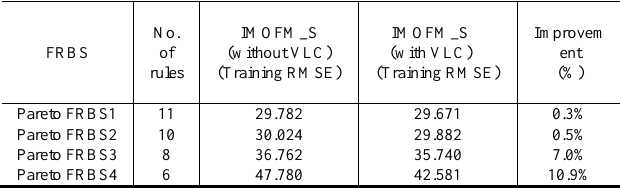
Table 5. The comparison of the modeling approaches with and without variable length coding